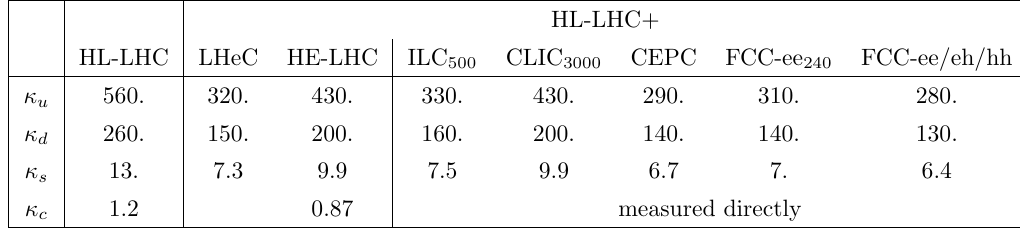
Table 13 . Upper bounds on the (cid:20) i for u , d , s and c (at hadron colliders) at 95% CL, obtained from the upper bounds on BR unt in the kappa-3